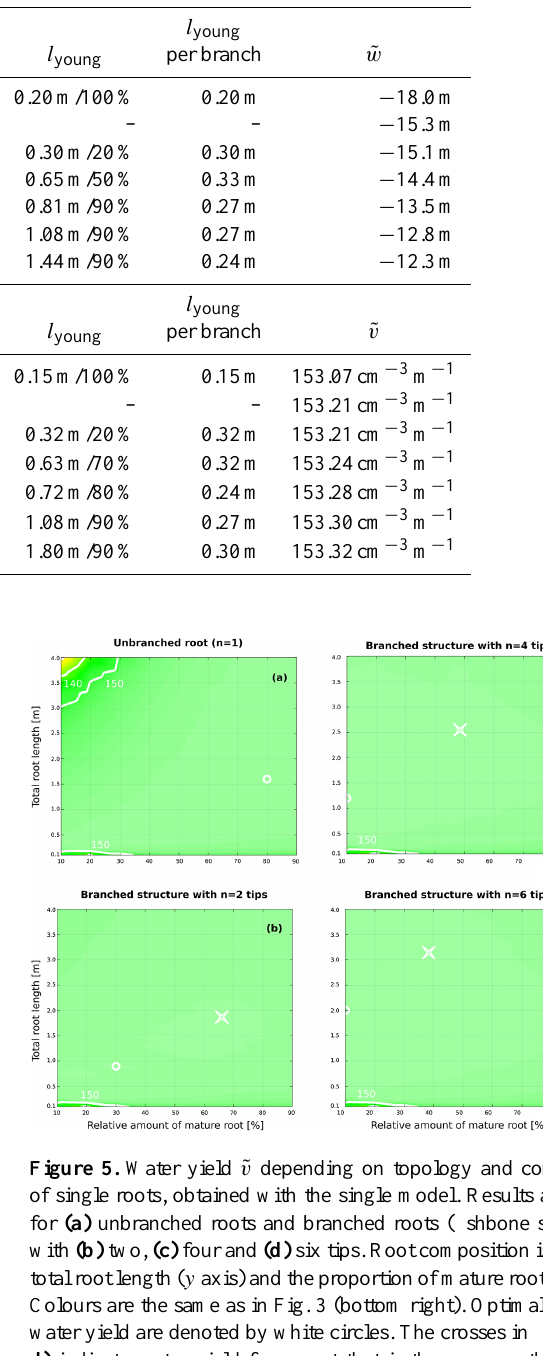
Table 2. Optimal compositions of single roots referring to effort (top) and water yield (bottom). Results are obtained with the simple model for different root topologies.